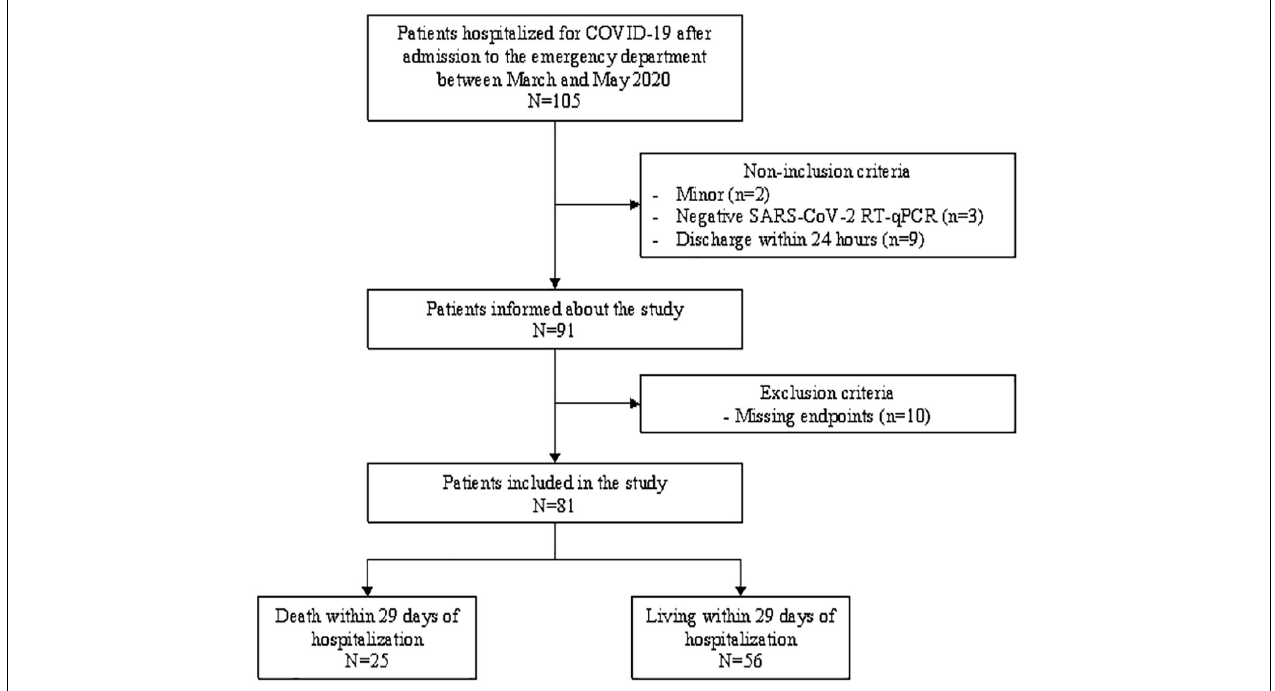
FIGURE 1 | Patient selection and longitudinal monitoring